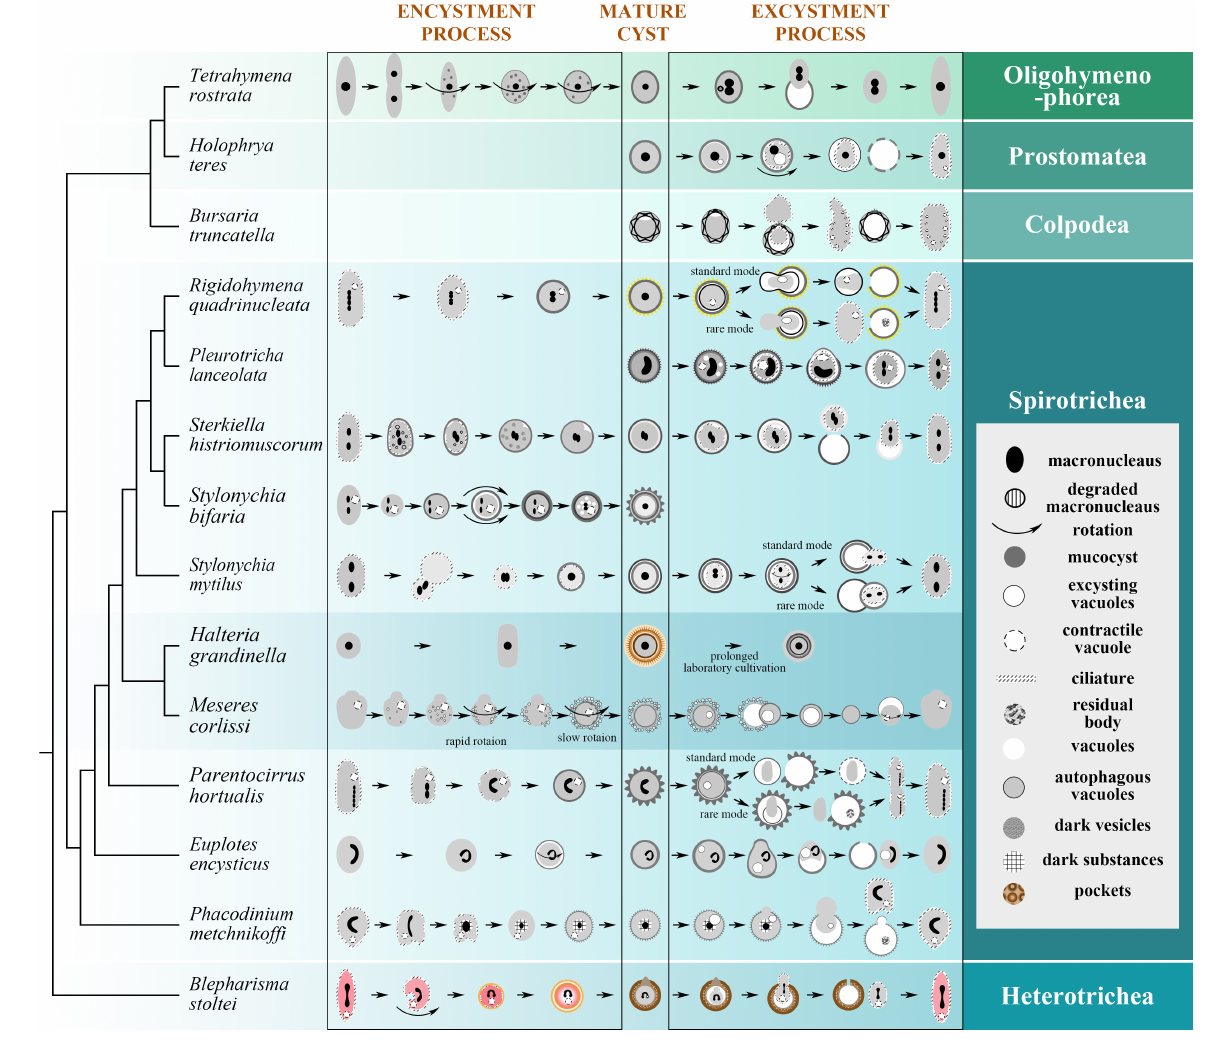
FIGURE 4 | Encystment and/or excystment process of 14 representative species in Figure 2 , with their phylogenetic relationships (Lynn, 2008; Berger, 2011; Gao et al., 2016; Wang J. et al., 2017; Wang et al., 2019). During the encystment process, the vegetative cells reduce in size, transform to spherical shape, absorb the ciliary structure, and secrete the CW; during the excystment process, the mature cysts restore some if not all vegetative structures within the CW prior to rupturing the CW and exiting. For the legend: macronuclei are not drawn in all stages for certain species; in Tetrahymena rostrata , the old macronucleus is degraded, while the new macronuclei are produced by the micronuclei; curved arrows indicate rotation and degree; mucocyst is secreted to form the cyst wall; degrading or regenerating ciliature is drawn as broken lines; vacuoles in Parentocirrus hortualis empty into the so-called contractile vacuole; pockets are disk-like structures consisting of unknown material. Tetrahymena rostrata (McArdle et al., 1980; Segade et al., 2016); Holophrya teres (Benˇcat’ová et al., 2020); Bursaria truncatella (Beers, 1948); Rigidohymena quadrinucleata (Benˇcat’ová and Tirjaková, 2017); Pleurotricha lanceolata (Jeffries, 1956); Sterkiella histriomuscorum (Adl and